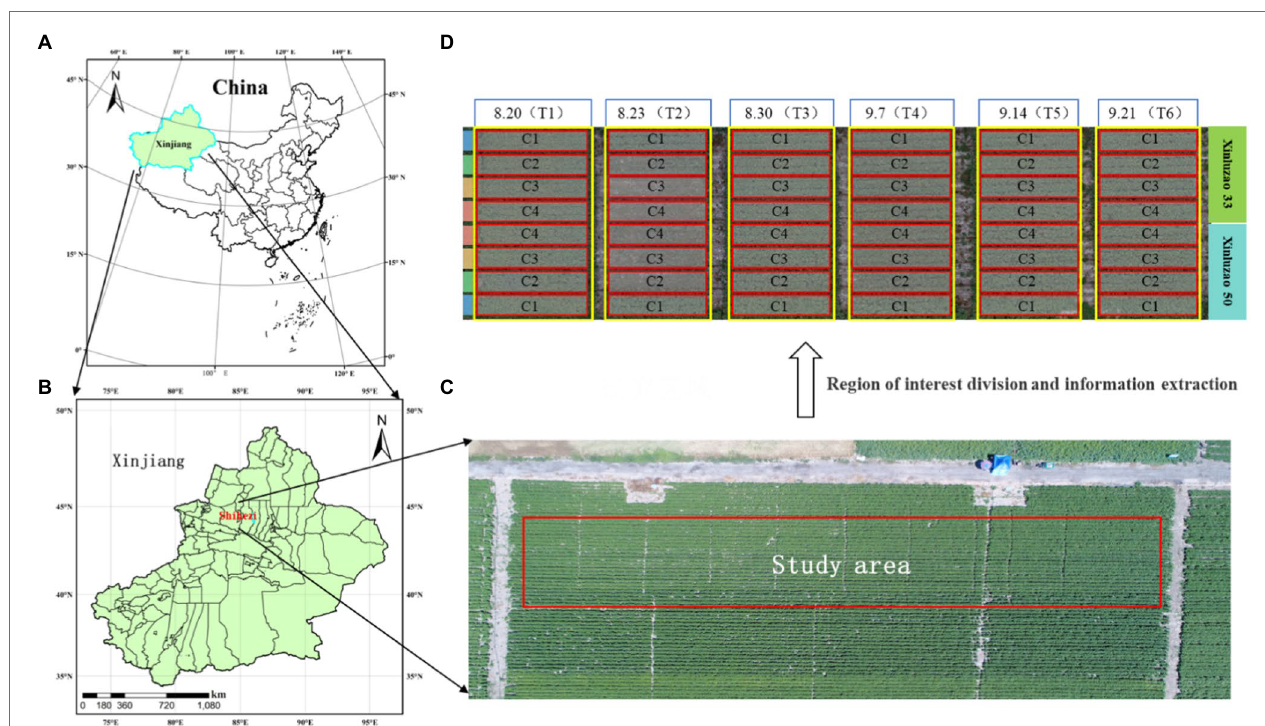
FIGURE 1 | Study area and experimental design: cotton experiment at Shihezi University Teaching and Testing Ground, Shihezi, Xinjiang, China in 2019–2020. Experimental including two local varieties of cotton. C1, C2, C3, and C4 denote different defoliant concentrations. T1–T3 denote different sprayed times. (A) Geographical location of Xinjiang; (B) Geographical location of Shihezi; (C) Study area; (D) Experimental